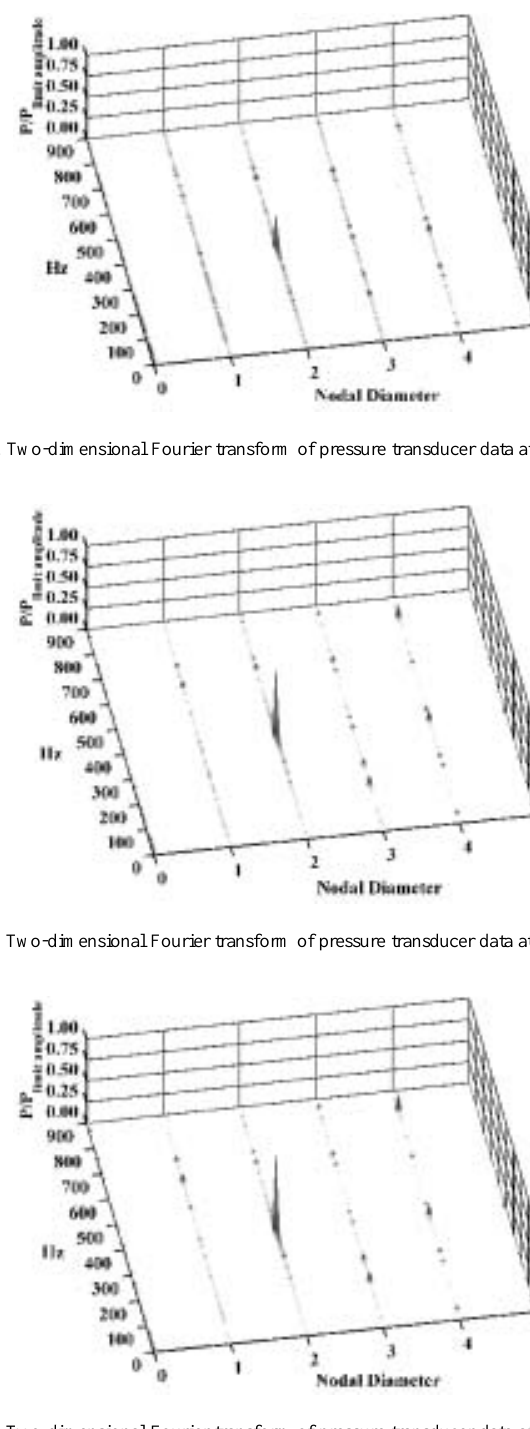
Fig. 17. Two-dimensional Fourier transform of pressure transducer data at 15